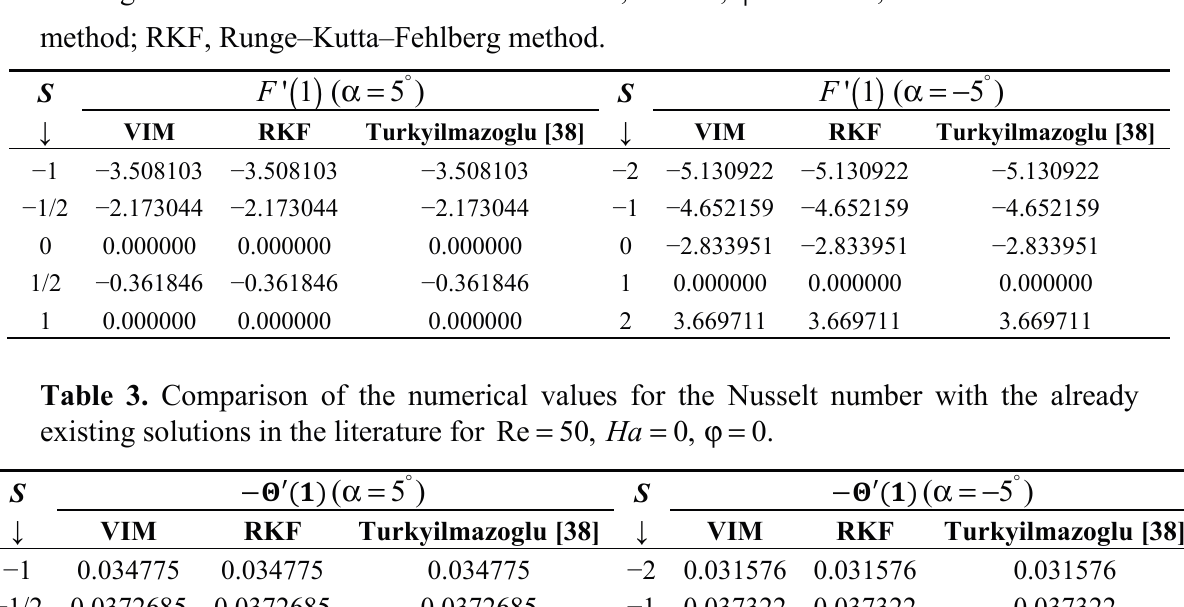
Table 2. Comparison of the numerical values for the skin friction coefficient with the already existing solutions in the literature for Re 50, VIM, variational iteration